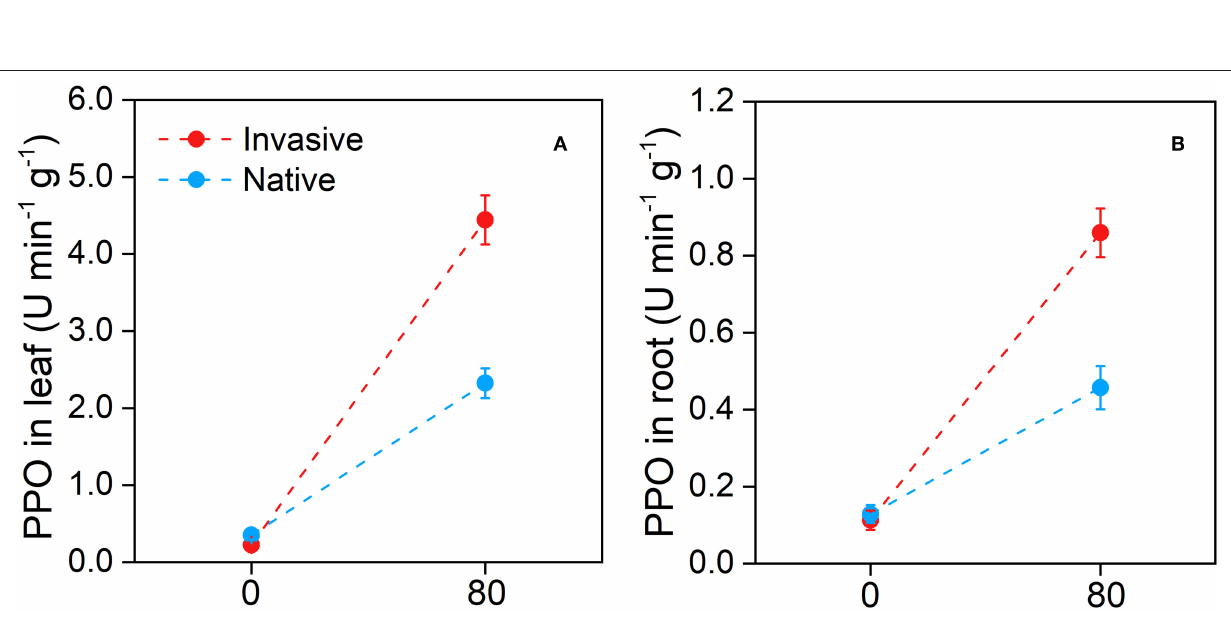
FIGURE 12 | Polyphenol oxidase in leaf (A) and in root (B) in the two group of invasive and native species under Cd 80 mg/kg level. Values are means ± standard error